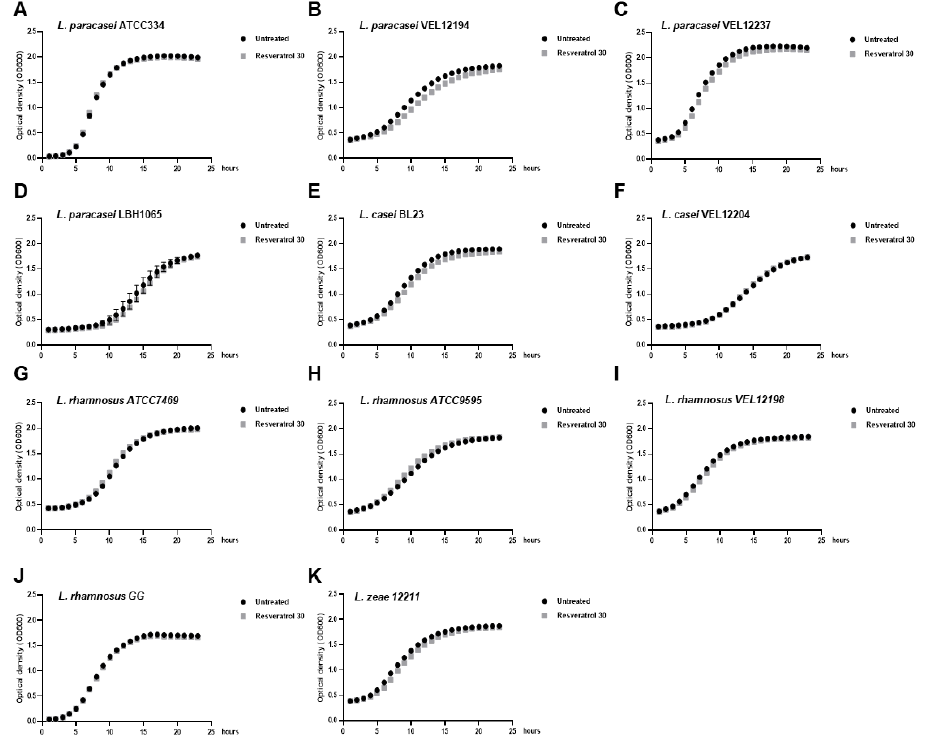
Figure A3. Growth curves of various Lacticaseibacillus strains with or without Resveratrol (30 µM) ( A– K ) Growth curves of various Lacticaseibacillus strains (name of the strain indicated on each graph) untreated (black filled circle) or incubated with 30 µ M (gray-filled square) Resveratrol in MRS medium at 37 ◦ C. The OD 600 was monitored at 1 h intervals for 23 h. Values represent mean ± SEM of three separate